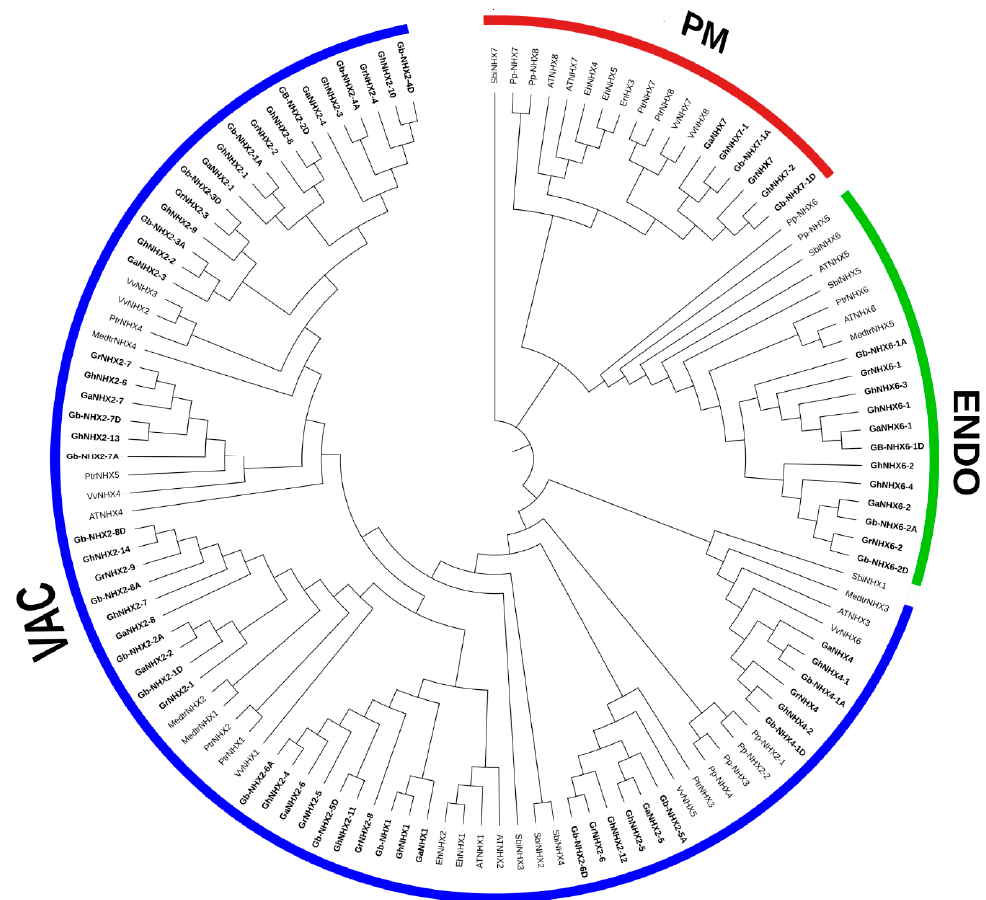
Figure 2. Phylogenetic tree of sodium transporters between the NHX transporters of 11 plant species by the neighbor-end joining method using MEGA 10.0. The tree divides all the 125 NHX genes into three groups based on their subcellular localization. Prefixes such as Gh, Gb, Gr, Ga, At, Vv, Ptr, Sb, Medtr, Eh, and Pp were used before the name of the species G. hirsutum , G. barbadense , G. raimondii , G. arboreum , A. thaliana , V. vinifera, P. trichocarpa , S. bicolor , M. truncatula , E. halophilum , and P. patens , respectively. G. barbadense genes are represented by bold letters. The amino acid sequences used in phylogenetic analysis are provided in Table